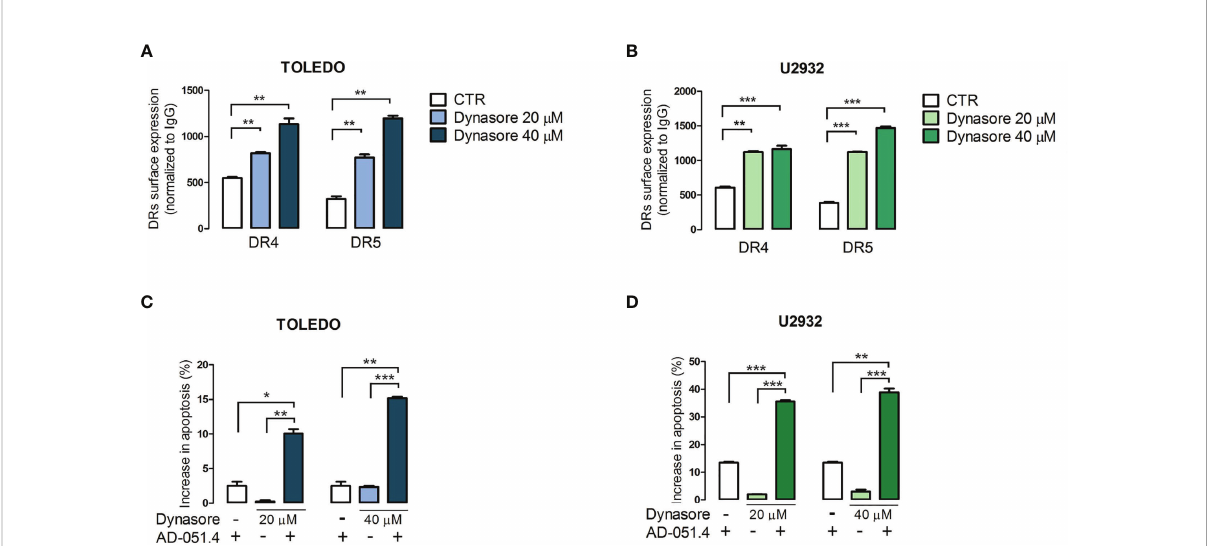
FIGURE 8 Dynamin inhibition increases the surface expression of death receptors and increases sensitivity to AD-O51.4. A, B. Dynamin inhibitor dynasore increases surface DR4 and DR5 expression in TOLEDO and U2932 in a dose-dependent manner. Cells were incubated with DMSO (control) or 20 - 40 m M dynasore for 30 minutes and fi xed to prevent further endocytosis/recycling of DR4 and DR5. The expression of death receptors was assessed by fl ow cytometry. Bars indicate mean fl uorescence intensity (MFI) normalized to isotype-matched antibody. Data represents an average of 3 experiments, error bars represent standard deviations. C, D. Inhibition of endocytosis sensitizes primary resistant TOLEDO and U2932 cells to AD-O51.4 -induced apoptosis. Cells were pretreated with dynasore (20 - 40 m M) for 1 h and treated with 0.1 nM AD-O51.4 for 24 h. Apoptosis was determined using Annexin V/PI staining. Bars indicate the average of the combined fraction of early and late apoptotic cells (PI-/AnnexinV+ and PI+/AnnexinV+, respectively) from two replicates. Error bars indicate standard deviations. In panels A-D, statistical differences were evaluated by t -test; *p-value<0.05, **p-value<0.005, ***p-value<0.001, ns – non signi fi